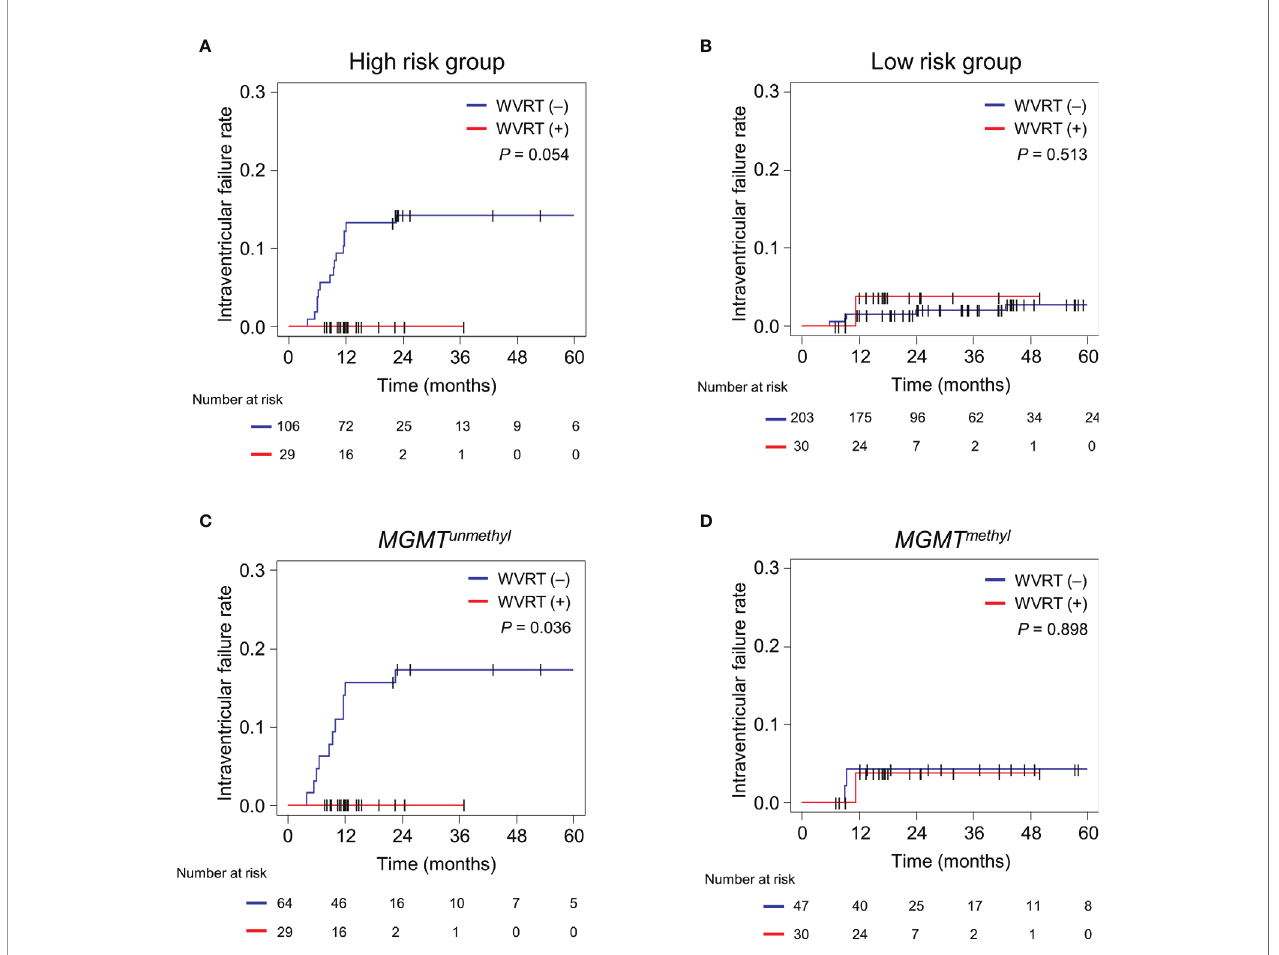
FIGURE 3 | Cumulative incidence rates of intraventricular failure in different subgroups. (A, B) Intraventricular failure rates in the RPA-classi fi ed high-risk group (n=135; A ) and low-risk group (n233; B ). (C, D) Intraventricular failure rates in the propensity score-matched cohort (n=170) with MGMT-unmethylated GBM (n=93; C ) and MGMT- methylated GBM (n=77; D ). The cumulative incidence rates were compared between the WVRT ( – ) and WVRT (+) groups. RPA, recursive partitioning analysis; WVRT, whole-ventricular